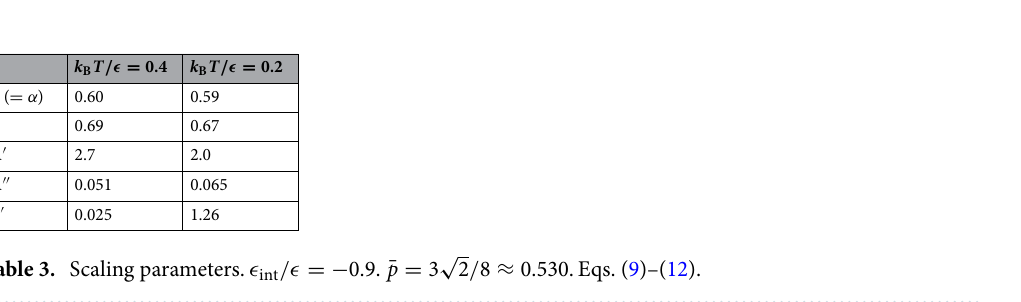
Table 3. Scaling parameters. ǫ int /ǫ